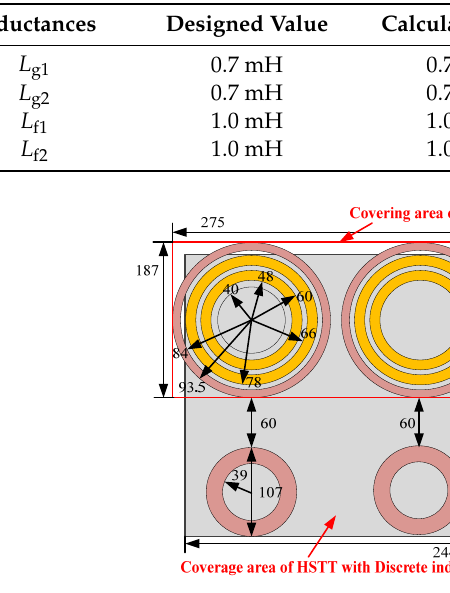
Figure 14. Comparison between the covering area of the HSTT with IFIs and that of discrete inductors (units = mm).